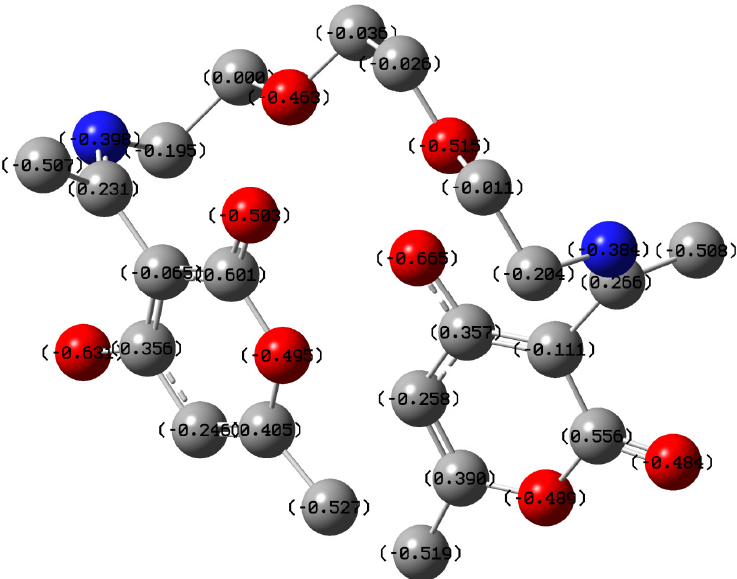
Figure 9. HOMO and LUMO surfaces of SB at an isosurface value of 0.02.